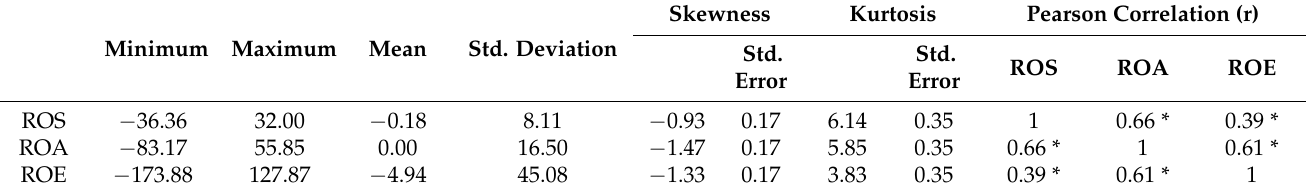
Table 4. Descriptive Statistics (N = 190)—Hungarian companies sample (without outliers).